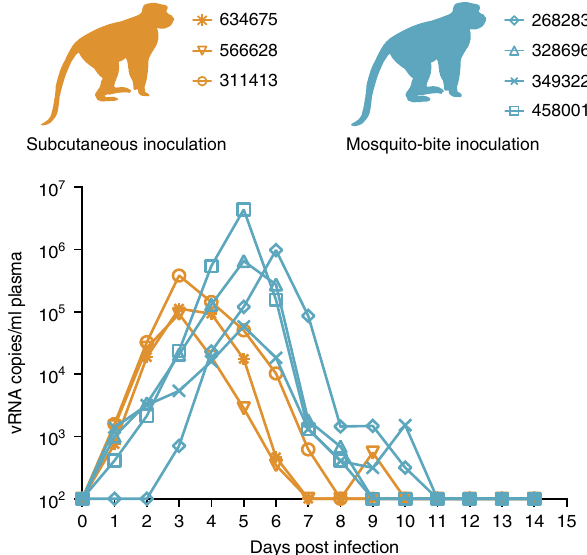
Fig. 1 Longitudinal detection of Zika vRNA in plasma in subcutaneously inoculated animals (orange) or animals challenged via mosquito bite (blue). Zika vRNA copies per ml blood plasma. The y axis crosses the x axis at